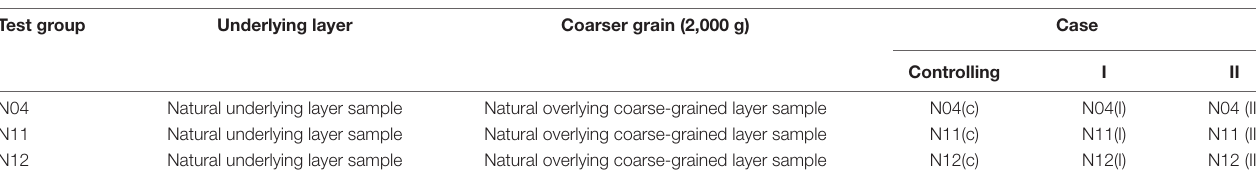
TABLE 2 | Test group information of natural debris flow